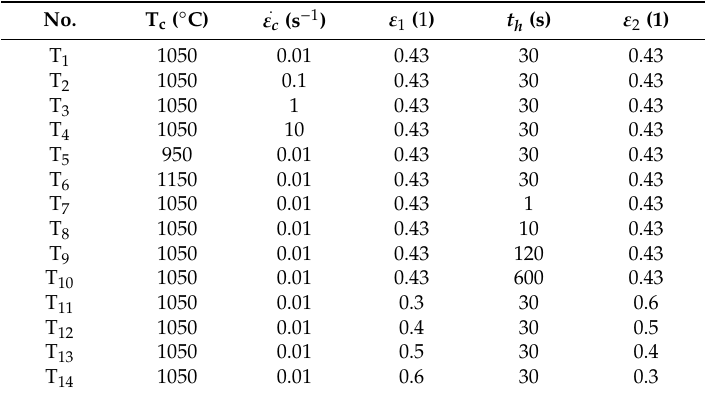
Figure 1. Experimental procedures of ( a ) double-pass compressions, ( b ) triple-pass compression, ( c ) quadruple-pass compression. Table 1. Experimental parameters of double-pass compressions.